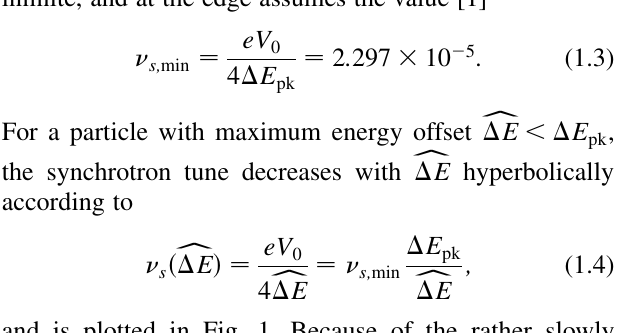
(cid:1) 0 , the barrier width T 2 (cid:1) 2 kV . Also shown in the plots are 0